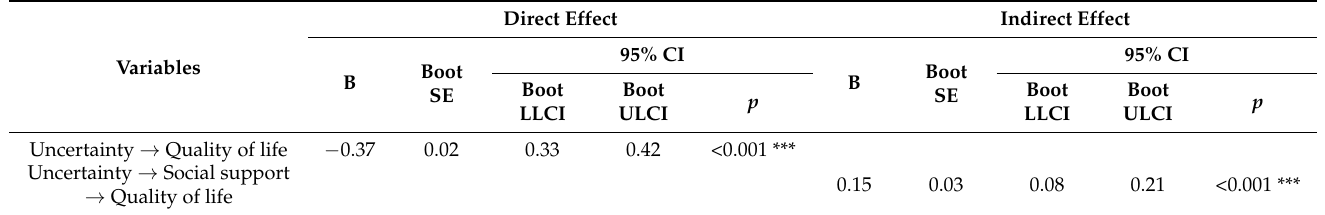
Table 4. Direct and indirect effects on quality of life (n = 155).